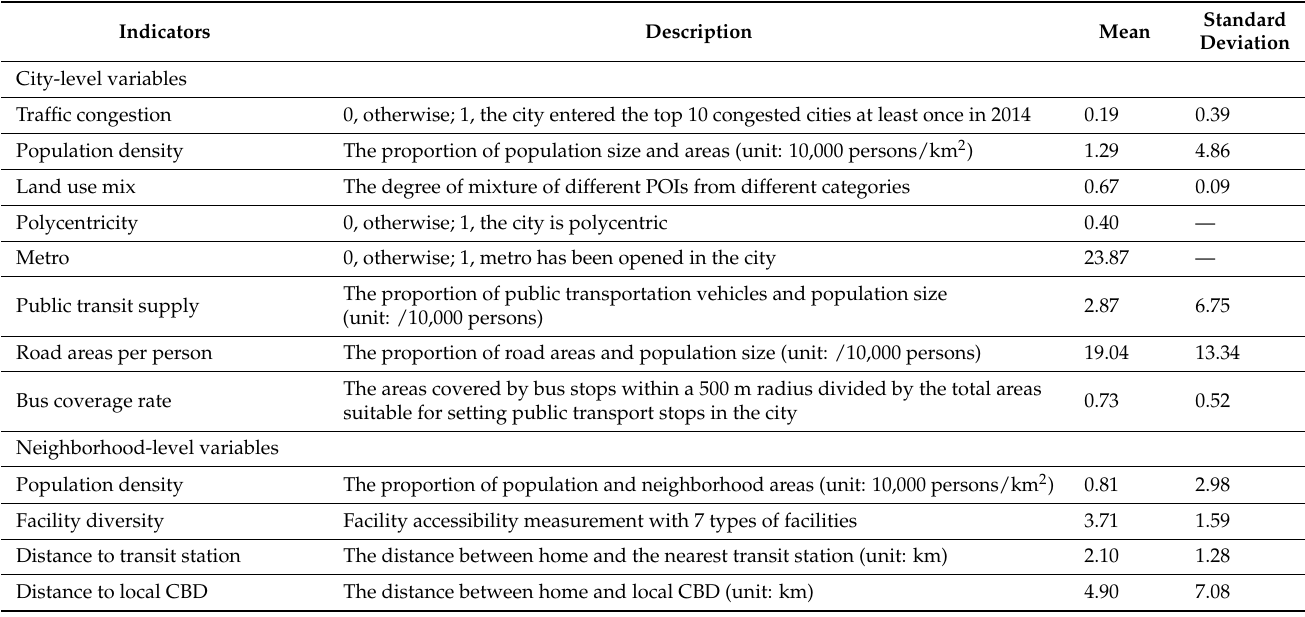
Table 3. Statistical descriptions of neighborhood- and city-level